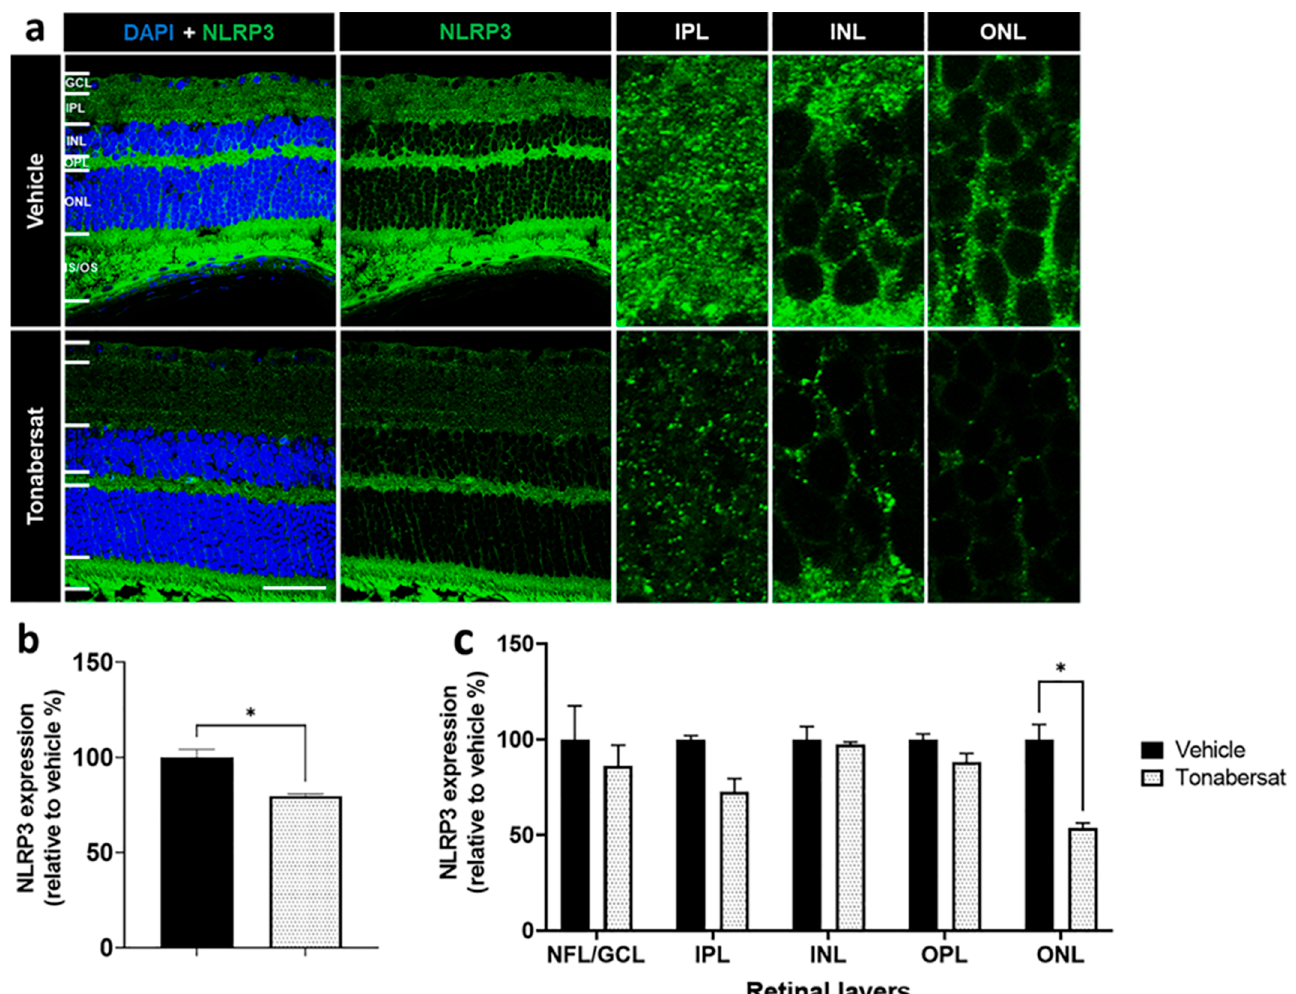
Figure 6. ( a ) NLRP3 expression was evident in both groups though overall levels appeared lower following tonabersat treatment compared to the vehicle group. GCL = ganglion cell layer; IPL = inner plexiform layer; INL = inner nuclear layer; OPL = outer plexiform layer; ONL = outer nuclear layer; IS/OS = inner and outer segments. Scale bar = 50 µm. ( b ) Tonabersat treatment significantly decreased overall NLRP3 levels relative to the vehicle group. Statistical analyses were carried out using a Student’s t -test. ( c ) Quantification of NLRP3 spots indicative of inflammasome complex assembly within specific retinal layers suggests that tonabersat reduced the number of NLRP3 spots significantly only in the ONL. Data are presented as a mean + SEM. Statistical analyses were carried out using two-way ANOVA with Sidak’s multiple comparison’s test. * p ≤ 0.05. n = 8–12 eyes per group. The tonabersat treatment (39.64 ± 1.20%, p = 0.0028) also decreased the number of cleaved caspase-1 spots, another marker of inflammasome complex assembly, within the retina compared to the vehicle group (100.00 ± 2.31%), especially within the IPL (20.09 ± 8.92% vs. 100.00 ± 2.86%, p = 0.0305), OPL (9.57 ± 2.43% vs. 100.00 ± 10.46%, p = 0.0137) and ONL (31.94 ± 16.67% vs. 100.00 ± 25.33%, p = 0.0457) (Figure 7b,c). There was a non-significant trend towards lower levels of cleaved caspase-1 within the NFL-GCL ( p = 0.2838) and INL ( p = 0.4273) with the tonabersat